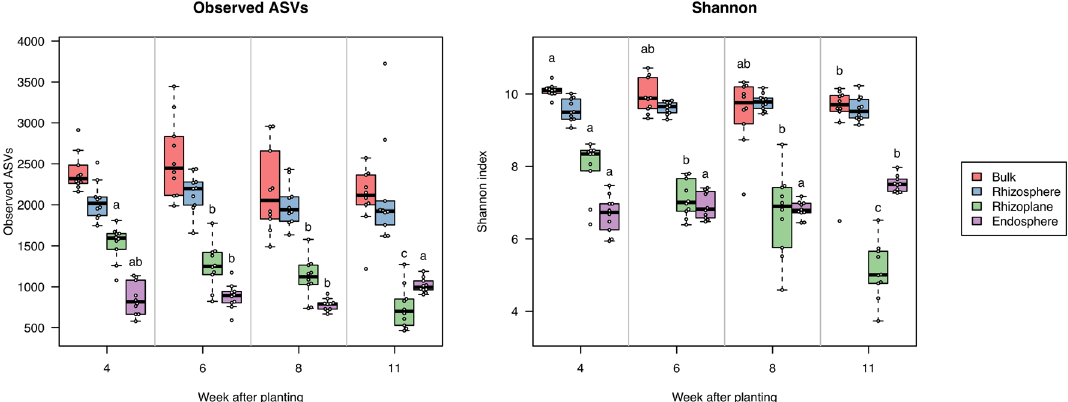
Figure 4. Alpha diversity of root-associated bacterial communities at different growth stages of field-grown soybean plants. Boxes showing different letters above them are significantly different among different growth stages ( p < 0.05, Kruskal–Wallis test with Benjamini–Hochberg